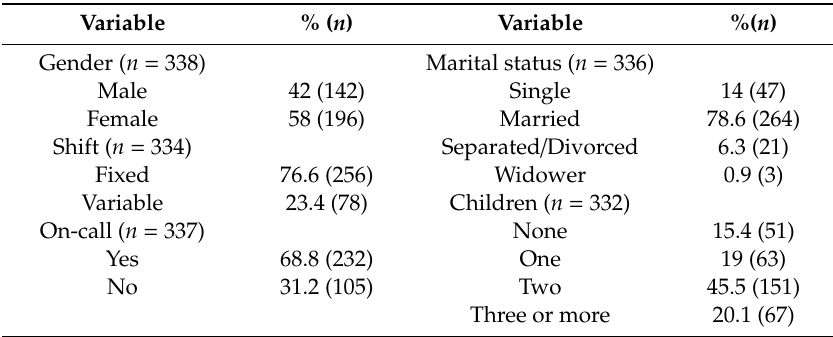
Table 1. Descriptive data for the qualitative study